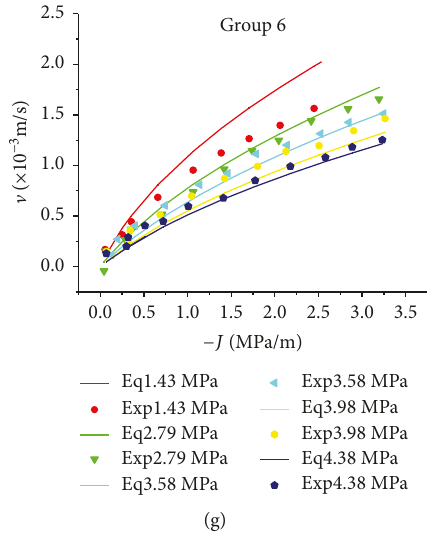
Figure 10: Result of comparison between predicated value and measured